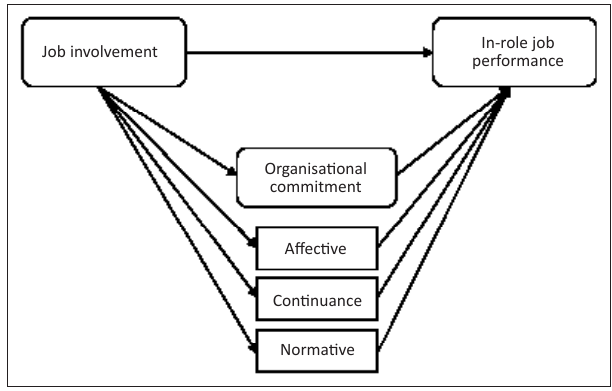
FIGURE 1: Research model showing mediating role of organisational commitment.